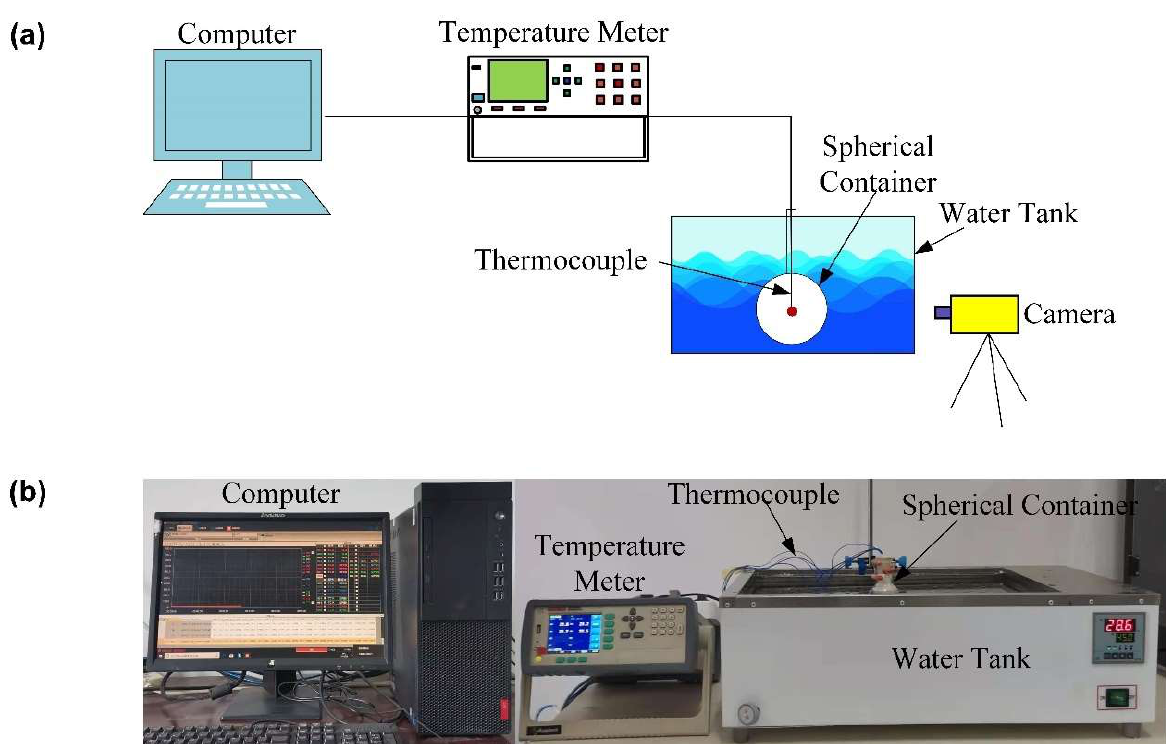
Figure 3. ( a ) Schematic diagram and ( b ) actual picture of the experimental setup for the constrained sample.